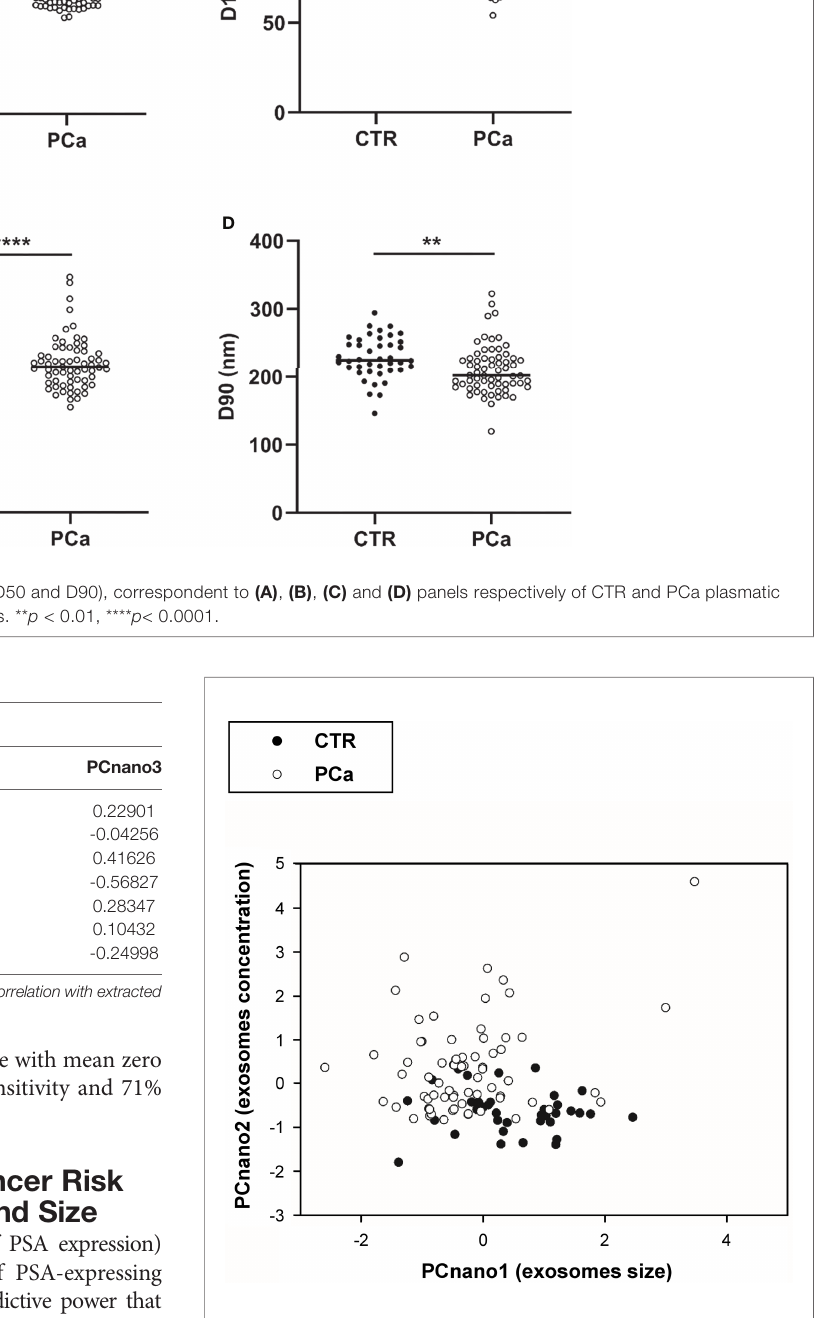
FIGURE 4 | Projection (component scores) of participants in the bi- dimensional space spanned by the two principal components (PCnano1 = exosome size component, and PCnano2 = exosomes number